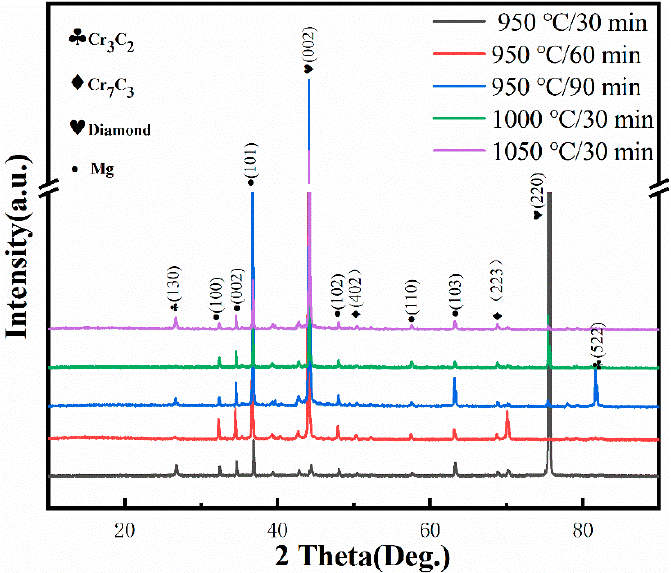
Figure 5. XRD patterns of Mg/diamond (Cr) composites with various coating parameters.